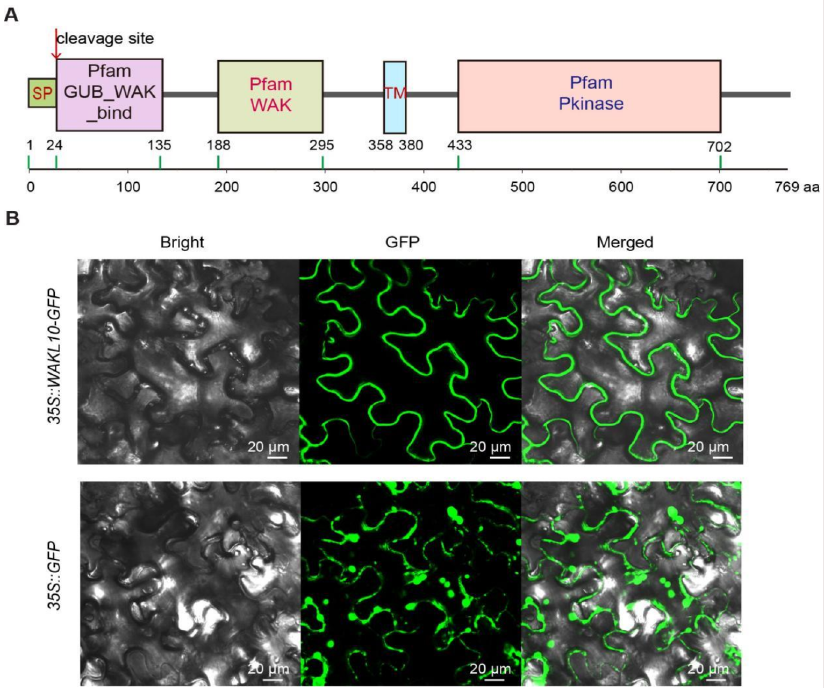
Figure 1. The domain composition and subcellular localization of AtWAKL10. ( A ) Diagram showing the significant domains and motifs predicted by the SMART program (http://smart.embl.de/, accessed on 12 March 2020). A signal peptide (SP) of 24 aa (aa 1 to 24) predicted by the SignalP-5.0 program (http://www.cbs.dtu.dk/services/SignalP/, accessed on 19 April 2021) is indicated in the light green box and the cleavage site is indicated with a red arrow. The accession for GUB_WAK, WAK, and protein kinase (Pkinase) is PF13947, PF08488, and PS5001, respectively. The amino acid (aa) positions for each domain are indicated by numbers above the green lines. TM: transmembrane domain. ( B ) 35::AtWAKL10-GFP and 35::GFP constructs were transiently transformed and expressed in Nicotiana benthamiana leaf epidermal cells for 3 d, then GFP signals were visualized on a confocal laser